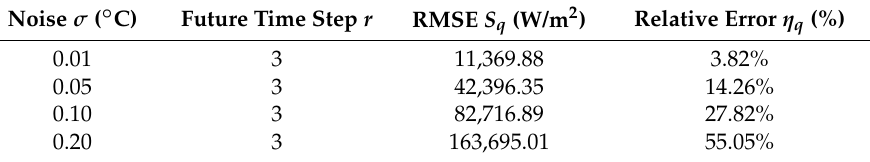
Figure 7. Inverse solution of heat flux under different temperature measurement noises: ( a ) σ = 0.01 ◦ C; ( b ) σ = 0.05 ◦ C; ( c ) σ = 0.10 ◦ C; and ( d ) σ = 0.20 ◦ C. Table 3. Error analysis for heat flux inversion under different measurement noises.